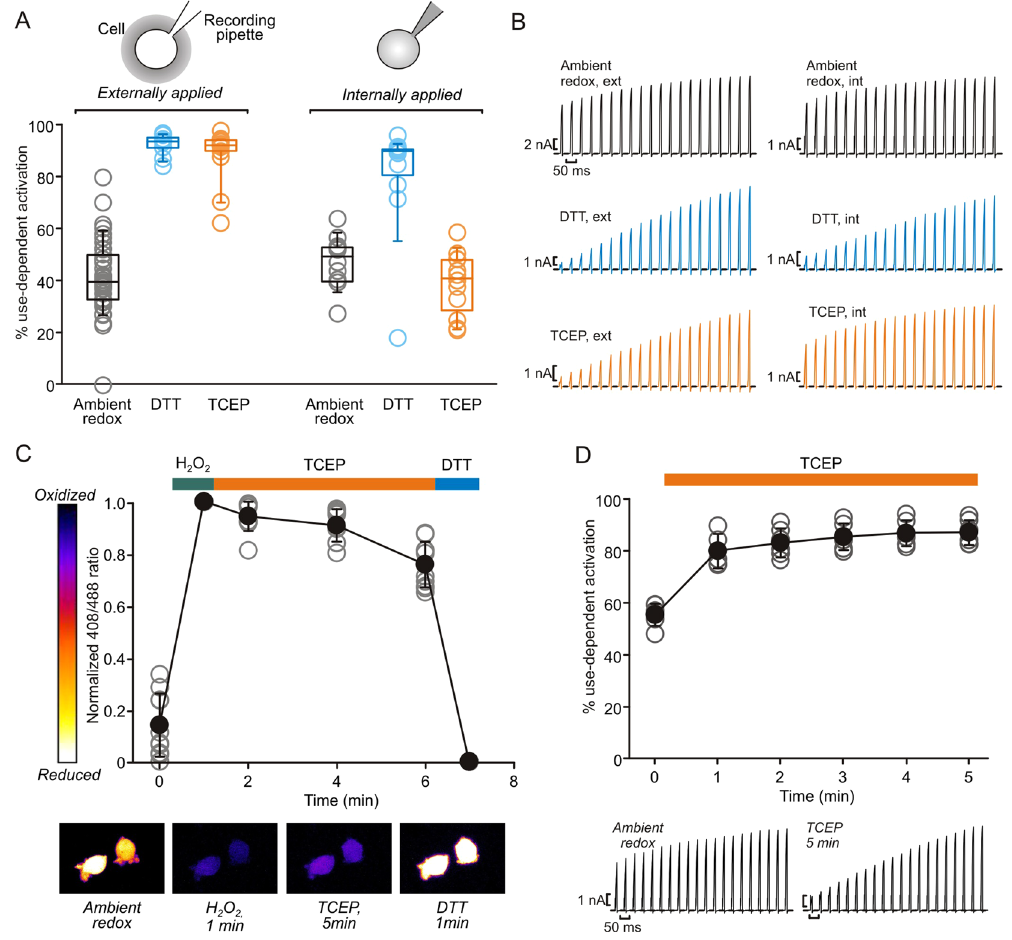
Figure 4. Extracellular redox environment modulates Kv1.2 use-dependent activation. ( A ) Use-dependent activation was assessed using repetitive depolarizations as described in Fig. 1. DTT (membrane permeant, blue) or TCEP (membrane impermeant, orange) reducing agents were applied intracellularly at 500 µ M (through the pipette solution) or extracellularly at 200 µ M, as indicated (External agents: N = 41 for ambient redox, N = 12 for DTT and N = 15 for TCEP; internal agents: N = 12 for ambient redox, DTT and TCEP). ( B ) Exemplar current traces from cells expressing Kv1.2 channels in various reducing agents illustrate the membrane sidedness of TCEP effects. ( C ) Mouse ltk- fibroblasts transfected with the genetically encoded redox sensor Grx1-roGFP were perfused with a range of redox active compounds, as indicated (H 2 O 2 at 1 mM, DTT and TCEP at 666 µ M). Extracellular TCEP provides minimal recovery of intracellular redox potential, while DTT rapidly reduces the intracellular compartment (black symbols = mean ± S.D., grey symbols are data from individual cells, N = 10). Pseudo-colouring was generated by the ‘Fire’ lookup table in ImageJ. ( D ) Use-dependent activation was assessed under ambient redox conditions (time = 0) with repetitive depolarizations as described in Fig. 1B, followed by perfusion with 200 µ M extracellular TCEP (N = 6). TCEP produces a maximal shift in use-dependent activation within 1–2 min, also illustrated with exemplar current traces in lower